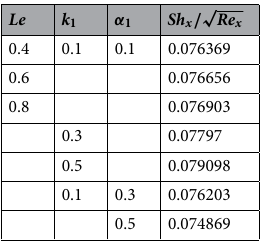
Table 5. The values of Nu x , for increasing Le , K 1 and α 1 when n = 0.2, β = 0.3, M = 0.2, ε = 0.2, Rd = 0.5, √ Re x Pr = 0.71, N b = 0.1 N t = 0.1, N = 0.1, (cid:31) = 0.1, Ec = 0.1, E = 2, δ = 0.5, m = 0.5, Bi 1 = 0.1, Bi 2 = 0.1, B r = 0.5, (cid:31) 1 = 2, χ =